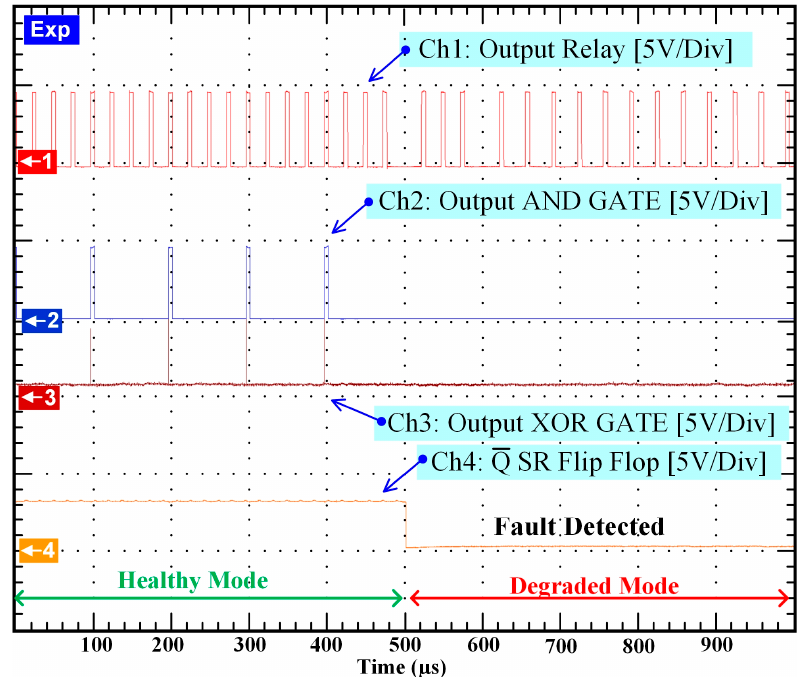
Figure 13. Experimental results: outputs of the fault diagnosis scheme to detect the failure.